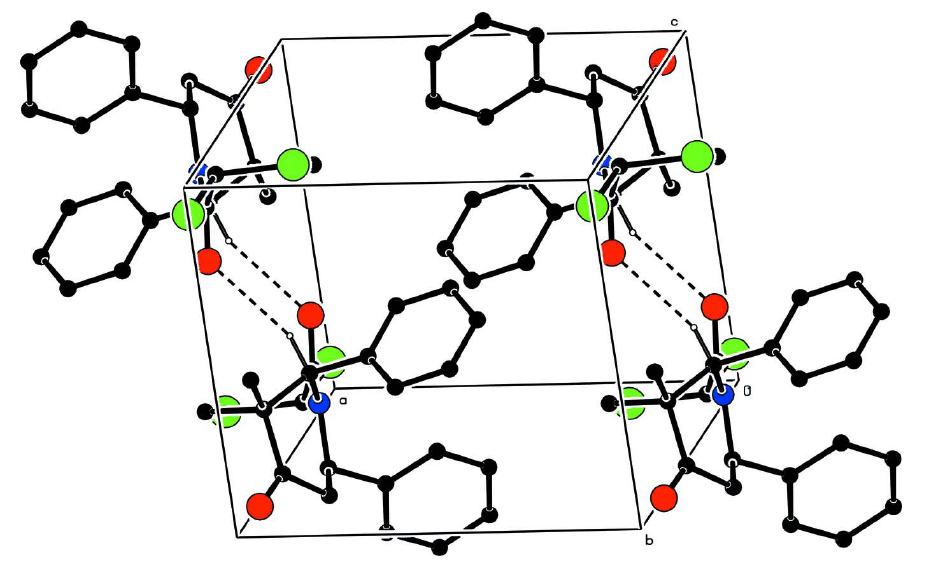
The crystal packing of the title compound, showing hydrogen-bonded (dashed lines) dimers. Atom H16A and H atoms not involved in hydrogen bonding have been